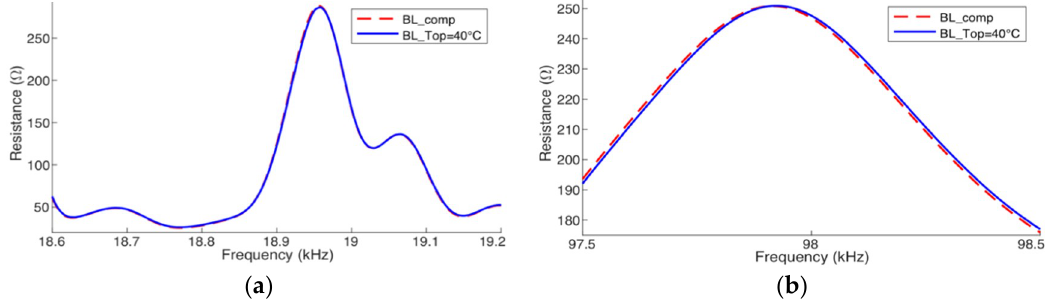
Figure 16. Complete compensation from +20 °C to +40 °C—Case 3 (Simulation) pipe-1/PZT-1: ( a ) at low frequency and ( b ) at high frequency.